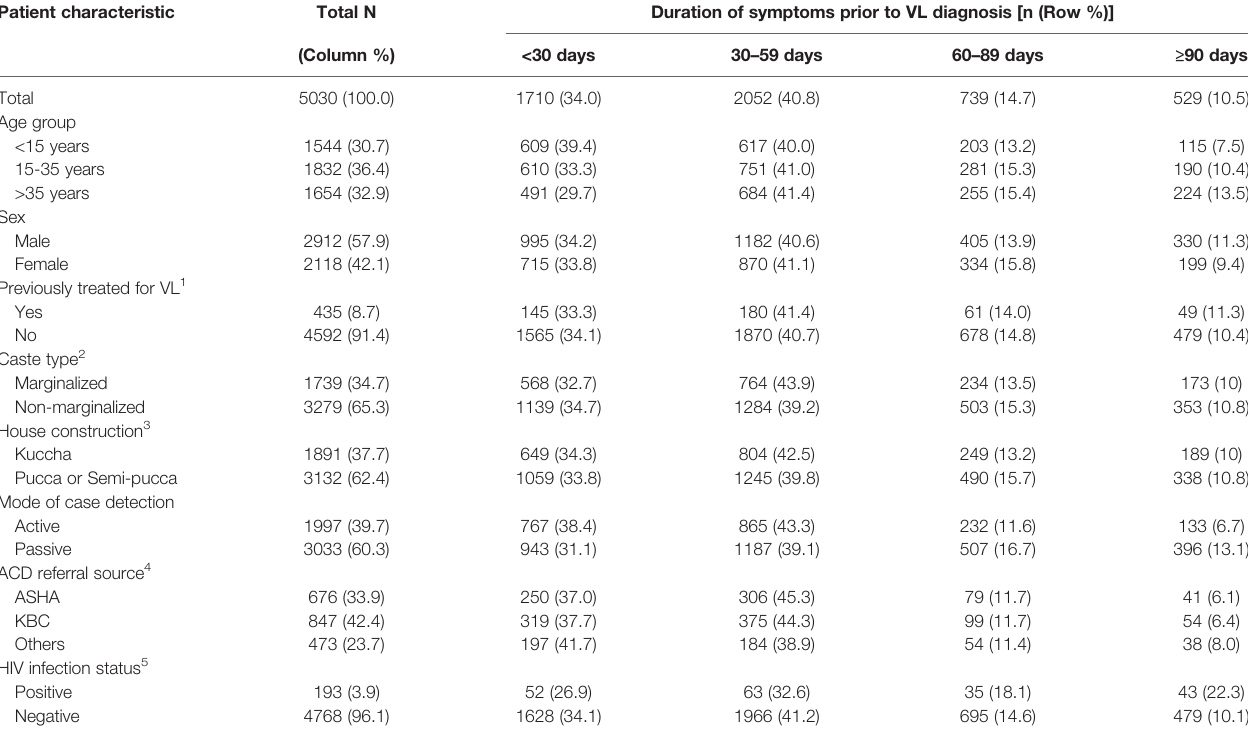
TABLE 1 | Characteristics of 5030 visceral leishmaniasis (VL) patients included in the current analysis, and distribution of symptom duration in days prior to diagnosis, Bihar State, India, January 2018 – July 2019. Patient characteristic